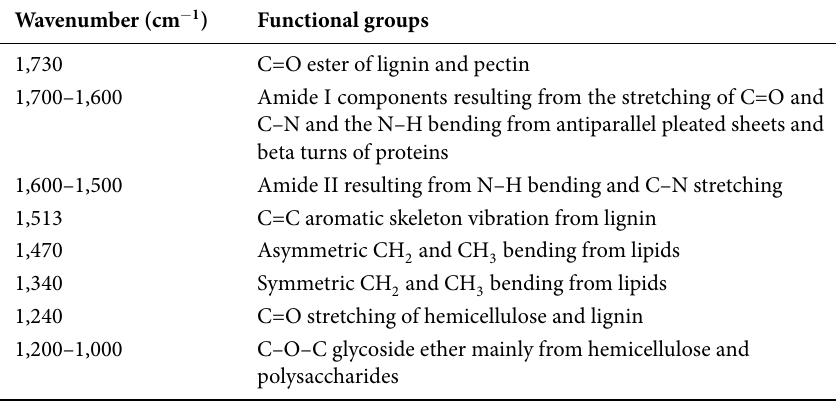
Table 2 Waveband assignments of the plant FTIR spectra (anh et al., 2017; umanu et al.,